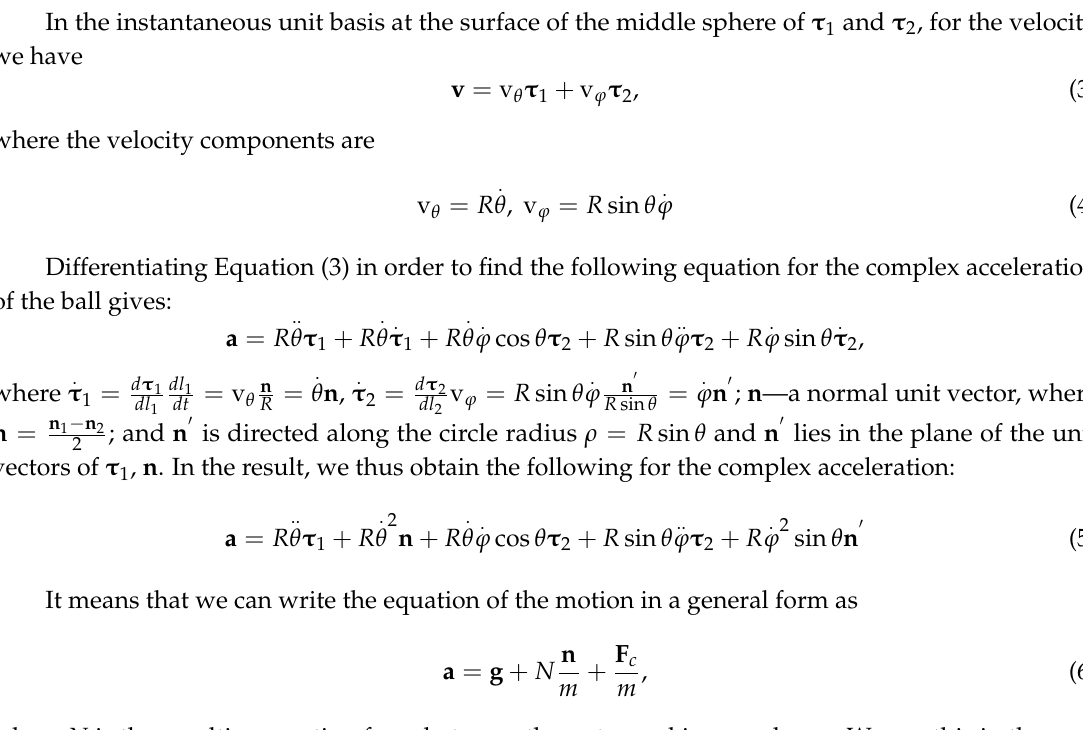
 azimuth, —polar bearing of the spherical coordinate system, angle     .